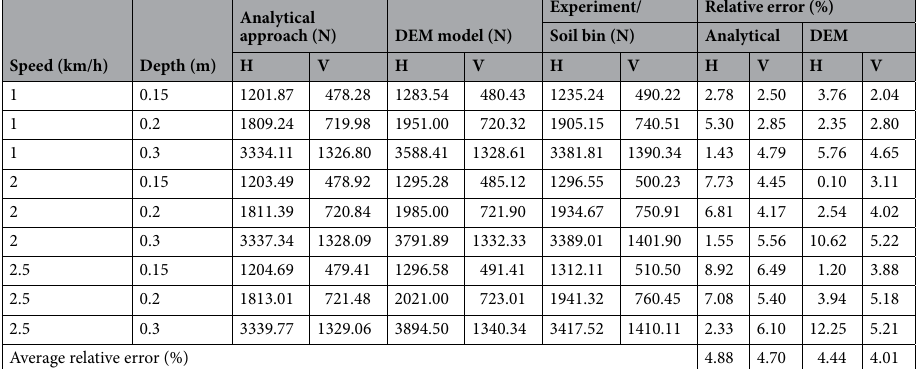
Table 4. The forces measured during the tillage experiments in the soil bin, analytical approach, and the numerical model. H, V- Indicates horizontal and vertical forces respectively.